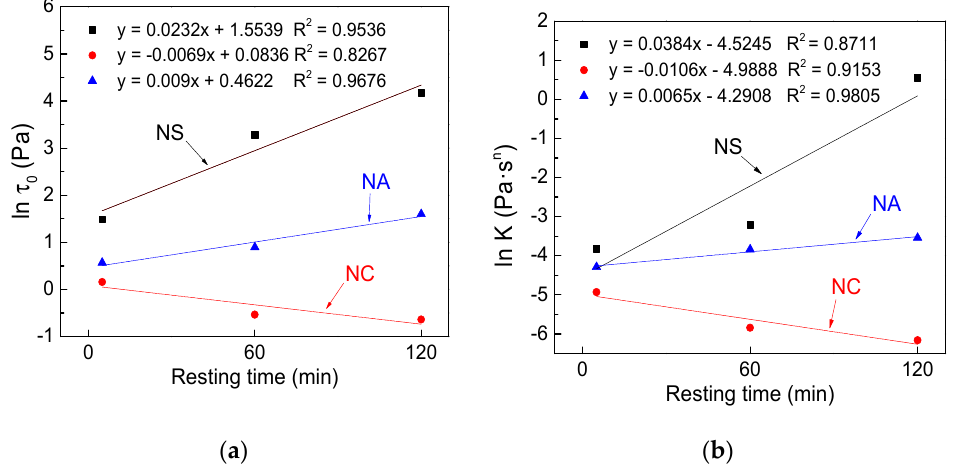
Figure 31. Influence of resting time on rheological parameters (1% content): ( a ) ln τ 0 and resting time; ( b ) ln K and resting time.